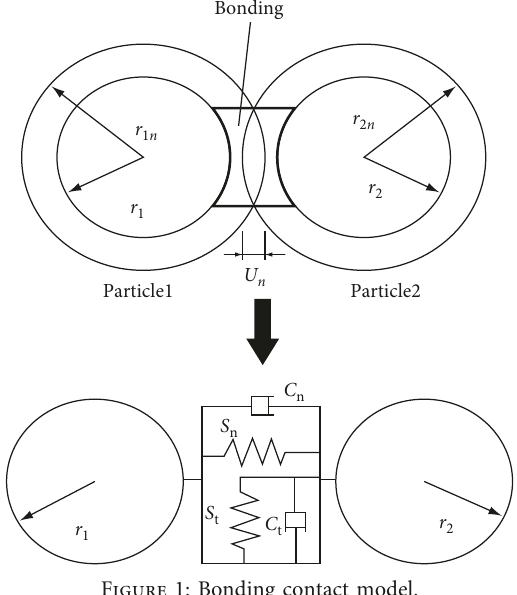
Figure 1: Bonding contact